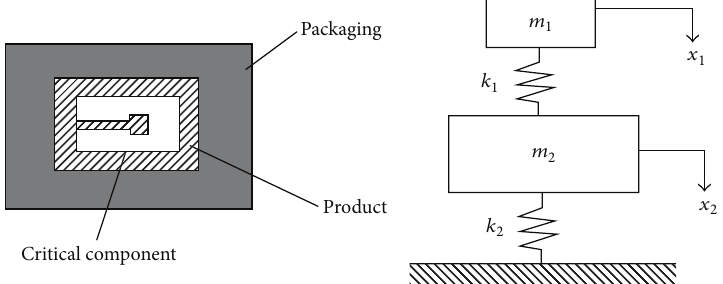
Figure 1: The model of packaging system with critical component ( 𝑚 1 ≪ 𝑚 2 ) and 𝑥 1 = 𝑥(𝑡) , 𝑥 2 = 𝑦(𝑡)